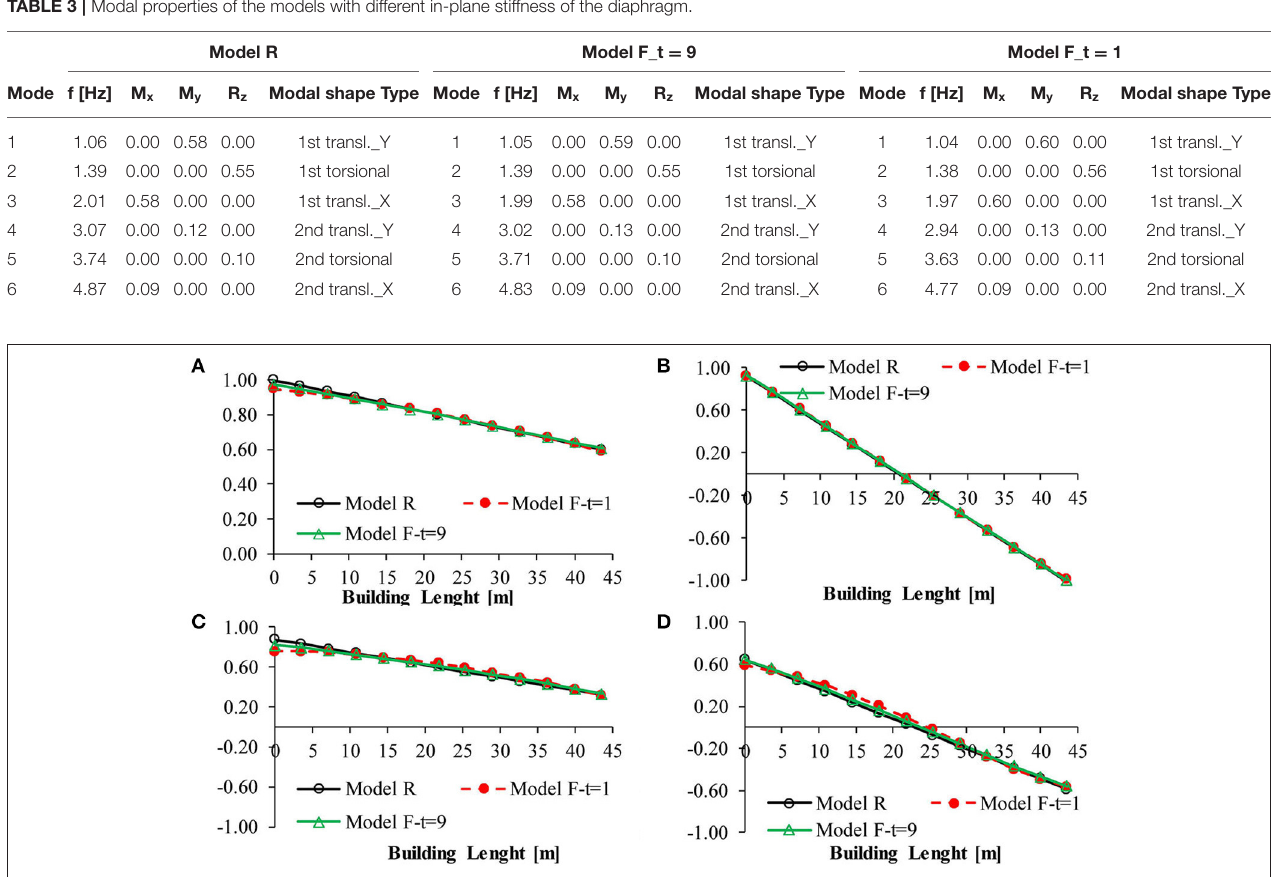
FIGURE 6 | Mode shapes for the roof diaphragm: (A) first translational Y; (B) first torsional; (C) second translational Y; (D) second torsional.